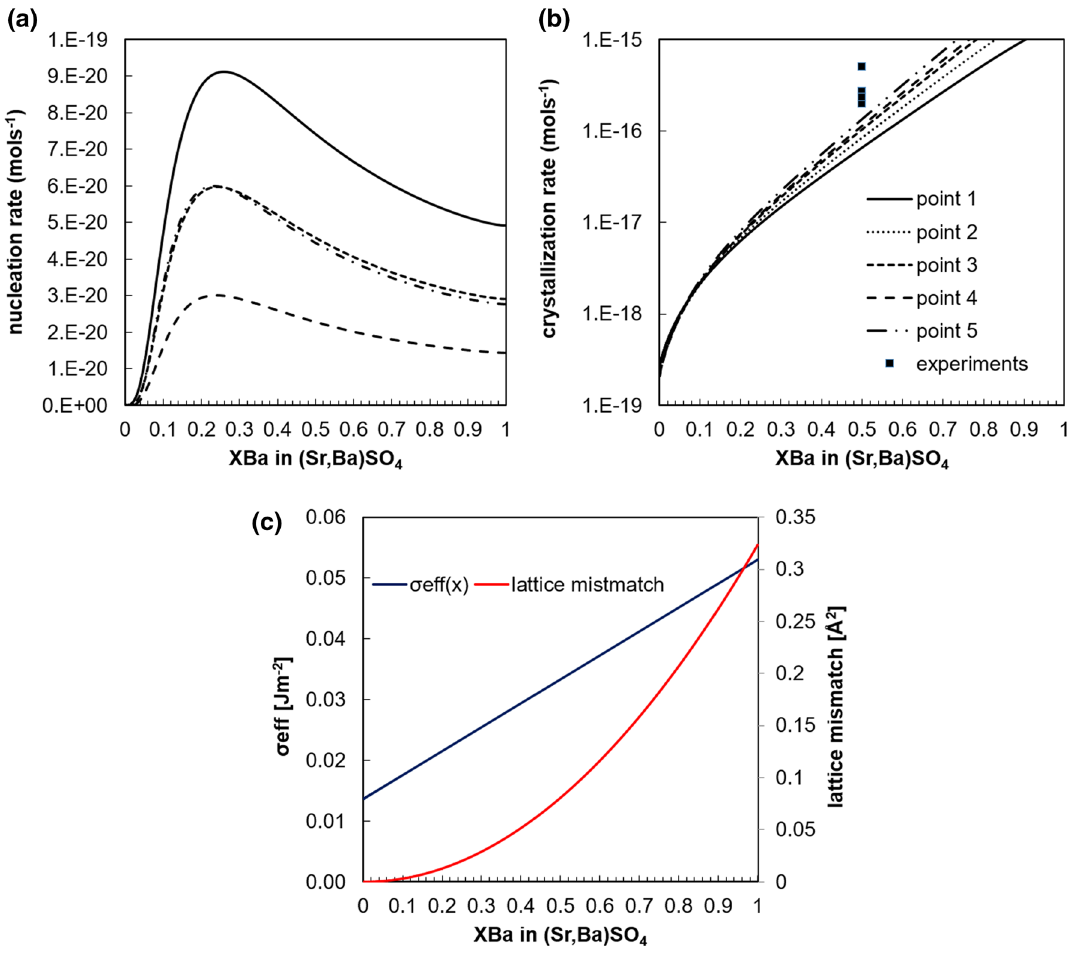
Figure 9. ( a ) Nucleation rates, ( b ) associated crystallization rates, and ( c ) calculated effective surface tension (primary vertical axis) and lattice mismatch (secondary vertical axis) as function of the solid solution To verify this hypothesis, we sampled the simulated aqueous solution composition at different locations (points 1–5 in Fig. 7a in case study 2) to compute the rate of nucleation and crystallization of (Ba,Sr)SO 4 solid solutions on the surface of Ba 0.05 Sr 0.95 SO 4 (Fig. 9). The sampled points typically reflect the solution composi- tion after the precipitation of Ba 0.05 Sr 0.95 SO 4 . The solution chemistry with aSr 2+ /aBa 2+ ~ 2, indicates that further nucleation of Ba 0.05 Sr 0.95 SO 4 is kinetically hindered but that other compositions with an increased Ba content can nucleate (shown by the maxima of the curves for points 1–5 in Fig. 9a). The precipitation of barium enriched phases is kinetically favoured via nucleation mechanisms. After the precipitation of Ba 0.05 Sr 0.95 SO 4 , the nucleation of barium enriched solid solutions becomes competitive enough to allow their precipitation. In fact, the switch to stoichiometric phases other than Ba 0.05 Sr 0.95 SO 4 could be explained by the fact that the nucleation rate of the other stoichiometric phases becomes higher than the rate of crystal growth of Ba 0.05 Sr 0.95 SO 4 . This successive nucleation and crystal growth operating at different rates (mol s −1 ) can also explain the experimentally observed oscillating crystallization rates in Fig. 7b. The solution chemistry after the precipitation of Ba 0.05 Sr 0.95 SO 4 favours crystallization of an almost pure barite (Fig. 8b), however, crystallization of solid solutions with compositions with X Ba > 0.6 on the surface of Ba 0.95 Sr 0.05 SO 4 is unlikely and was observed only once and after clogging at the pillars (crystal 3 in chamber 1), where the concentration of aqueous barium can build up in the system. Other factors related to the crystallog- raphy of the solid solutions could be decisive for the determination of the composition of the solid solutions that can precipitate. For instance, lattice mismatch (equation S7.1 in supplement S7) that characterizes the difference between the lattice parameters of the growing solid solution and its substrate. Due to significant differences in lattice parameters between the growing phase and the substrate (Fig. 9c), only specific phases can precipitate. Such phenomena are common for the epitaxial growth of sulphate solid solutions 9 . Similarly, the surface tension and therefore the energetic barrier associated with the growth of solid solutions with X Ba > 0.6 on the surface of Ba 0.95 Sr 0.05 SO 4 is relatively large, and is therefore unlikely to occur. The 1D continuum approach is limited to describe the processes occurring at the mineral-solution inter- faces, nevertheless, it provides strong evidence that oscillatory zoned crystals of (Ba,Sr)SO 4 are not solely the result of a diffusion induced precipitation process but rather depends on crystallization kinetics. The inclusion